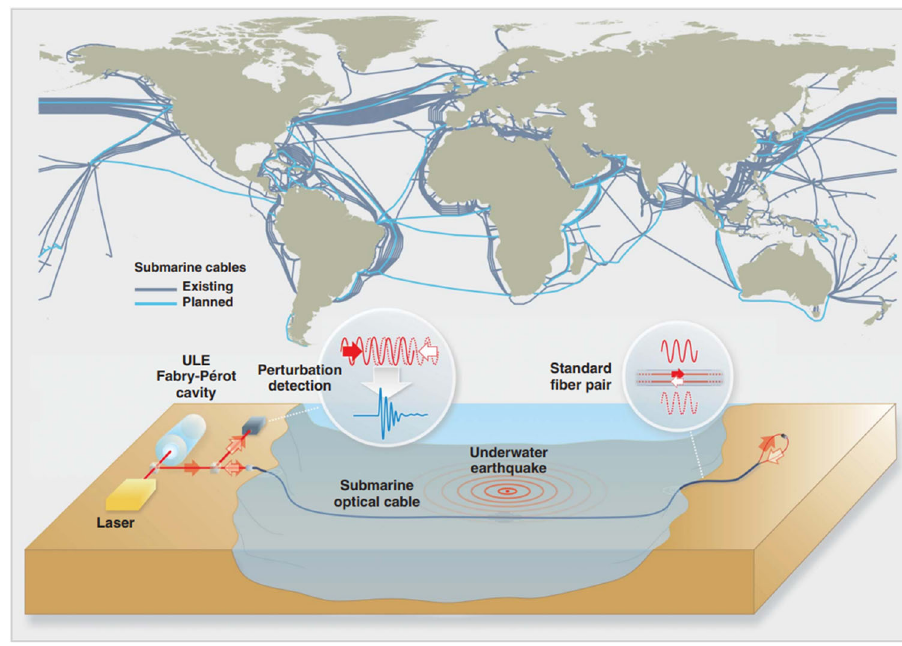
Figure 4. Detection of local and remote earthquakes using a laser based on FP cavities. Reprinted with permission from [75].